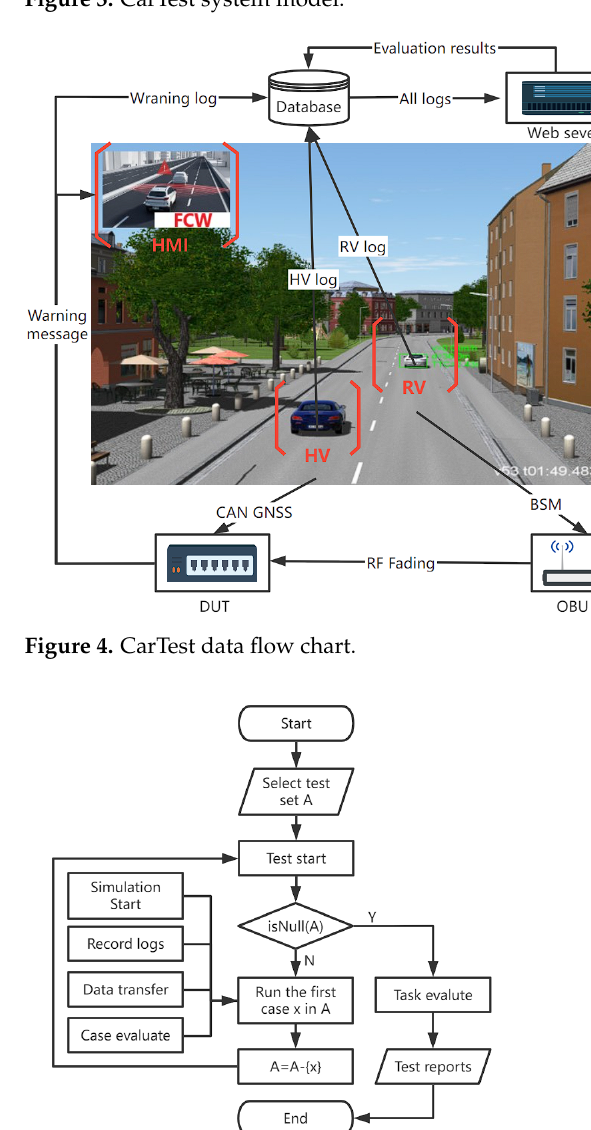
Figure 3. CarTest system model.